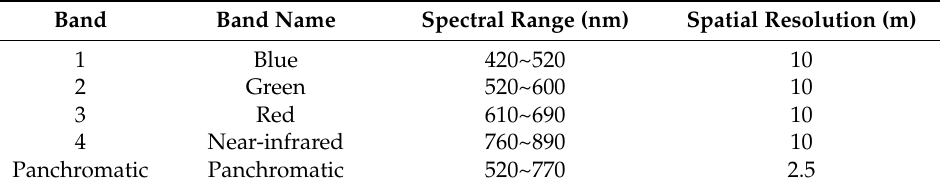
Table 1. Waveband parameters of the ALOS remote sensing images.